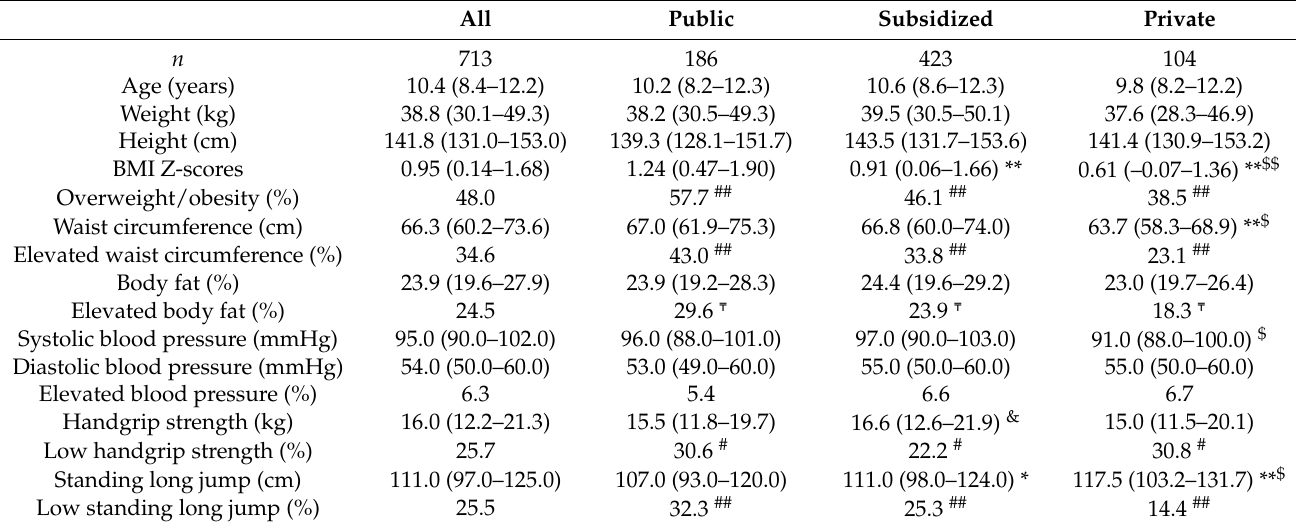
Table 3. Characteristics of girls by school